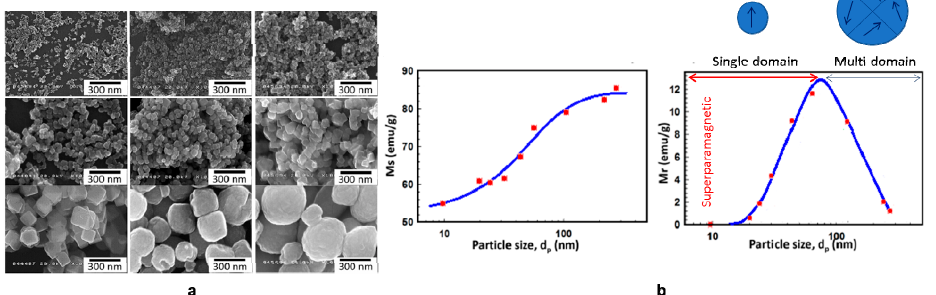
Figure 7. ( a ) Scanning electron microscopy images of cube-like Fe 3 O 4 nanoparticles with various particle sizes. ( b ) Cube-likeFe 3 O 4 nanoparticles size dependence of saturation magnetization and remnant magnetization. Red-circles represent cube-like nanoparticles. Modified from Reference [78].